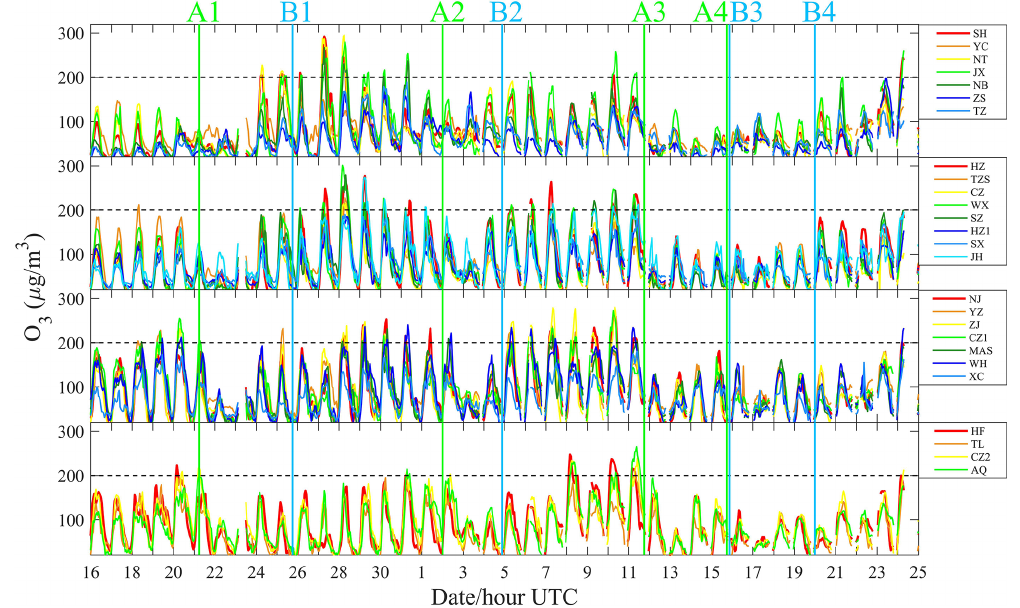
Figure 3. Diurnal variation of O 3 in 26 cities of the YRD from 16 June to 25 August 2018. The dotted gray lines are the national ambient air quality standard for hourly O 3 (200µgm − 3 ) in China. The letter A indicates the moment that the typhoon reached the 24h warning line, and the letter B indicates the last moment when the typhoon was active in mainland China. These times are acquired from the best-track TC dataset, depending on the start and end times of the 3h observations. Coordinates 1, 2, 3 and 4 represent Typhoon Ampil, Typhoon Jongdari, Typhoon Yagi and Typhoon Rumbia, respectively. Note: these cities are sorted by